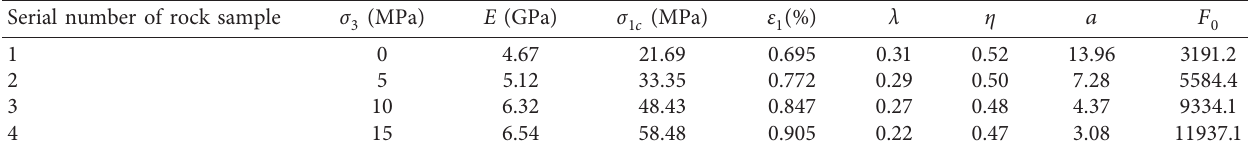
Table 2: Weibull distribution model parameters.